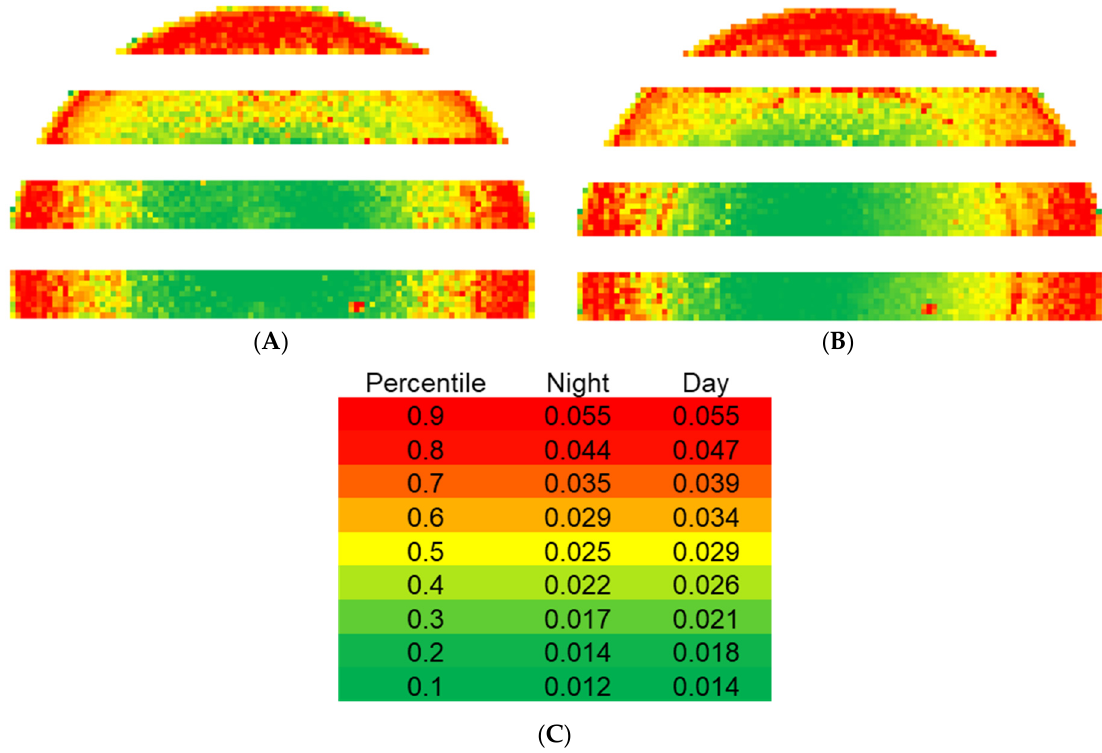
Figure 31. ( A ) Livox ® Mid – 40 and ( B ) Riegl ® VZ-400 point clouds generated from observations of the target surface. CloudCompare [21] was used to register the two datasets using the targets towards extraction of conjugate points for measured distance comparison (RMSE of 0.007 m, and 0.005 m for night and day target registrations, respectively).